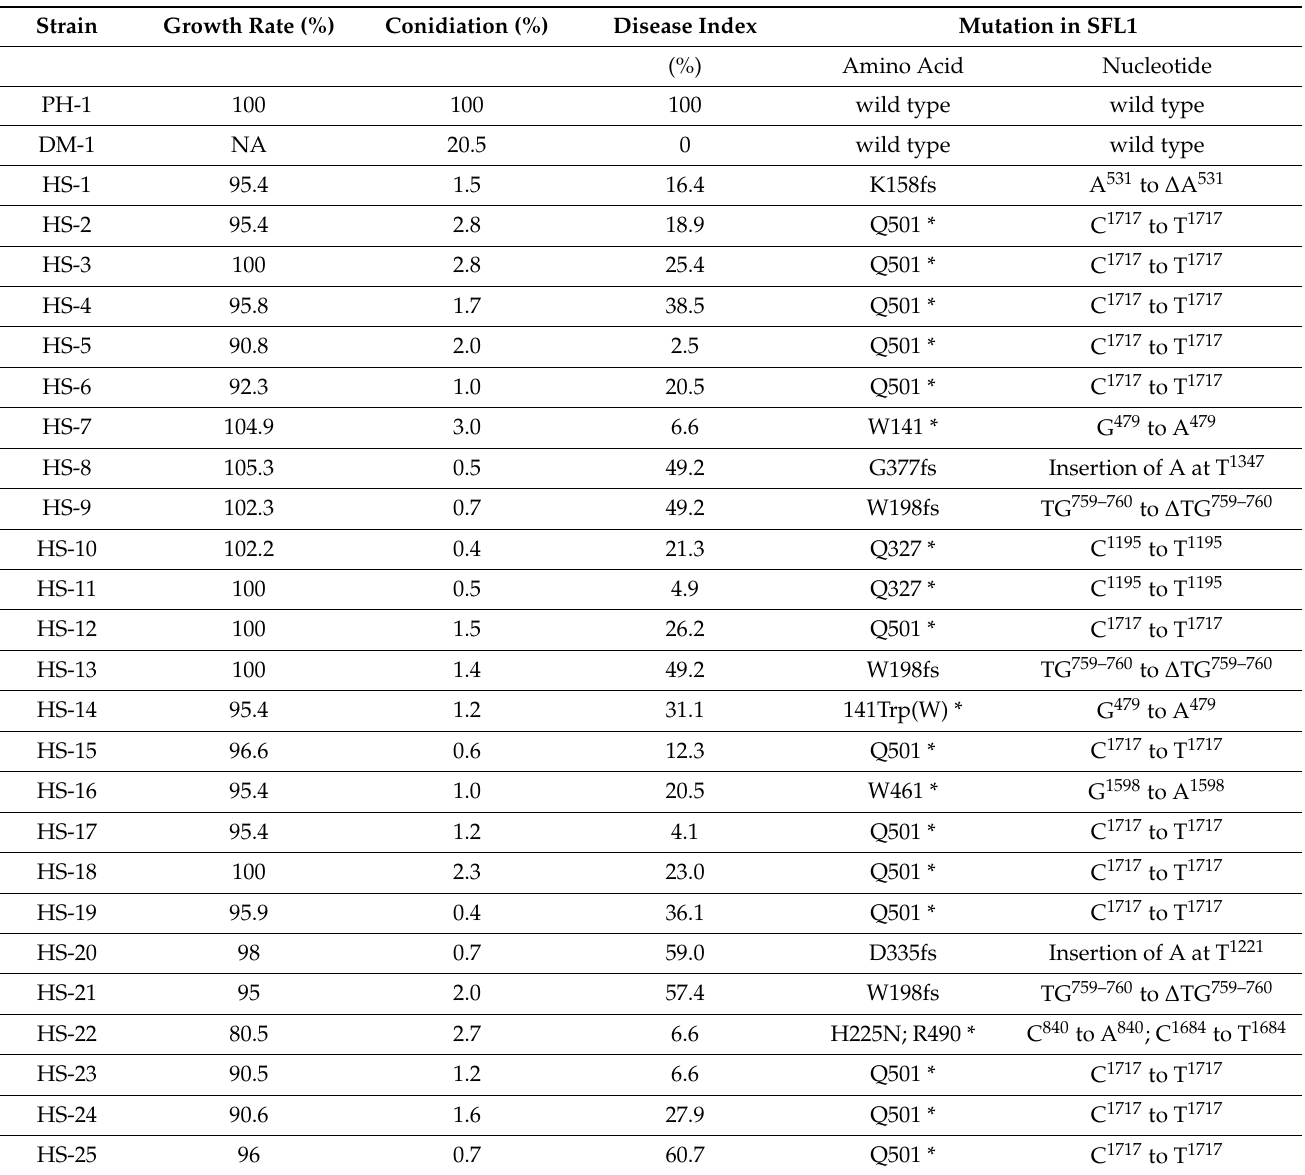
Table 2. Suppressor strains of the cpk1 cpk2 double mutant and their growth rate, conidiation, wheat infection index, and various mutations in